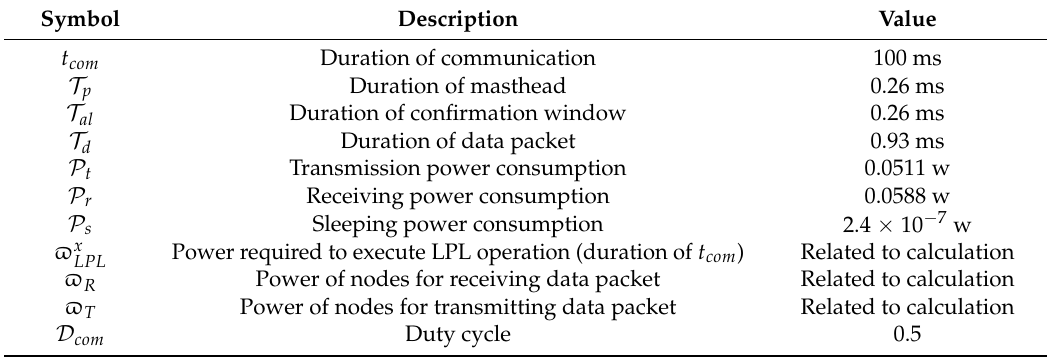
Table 1. Network